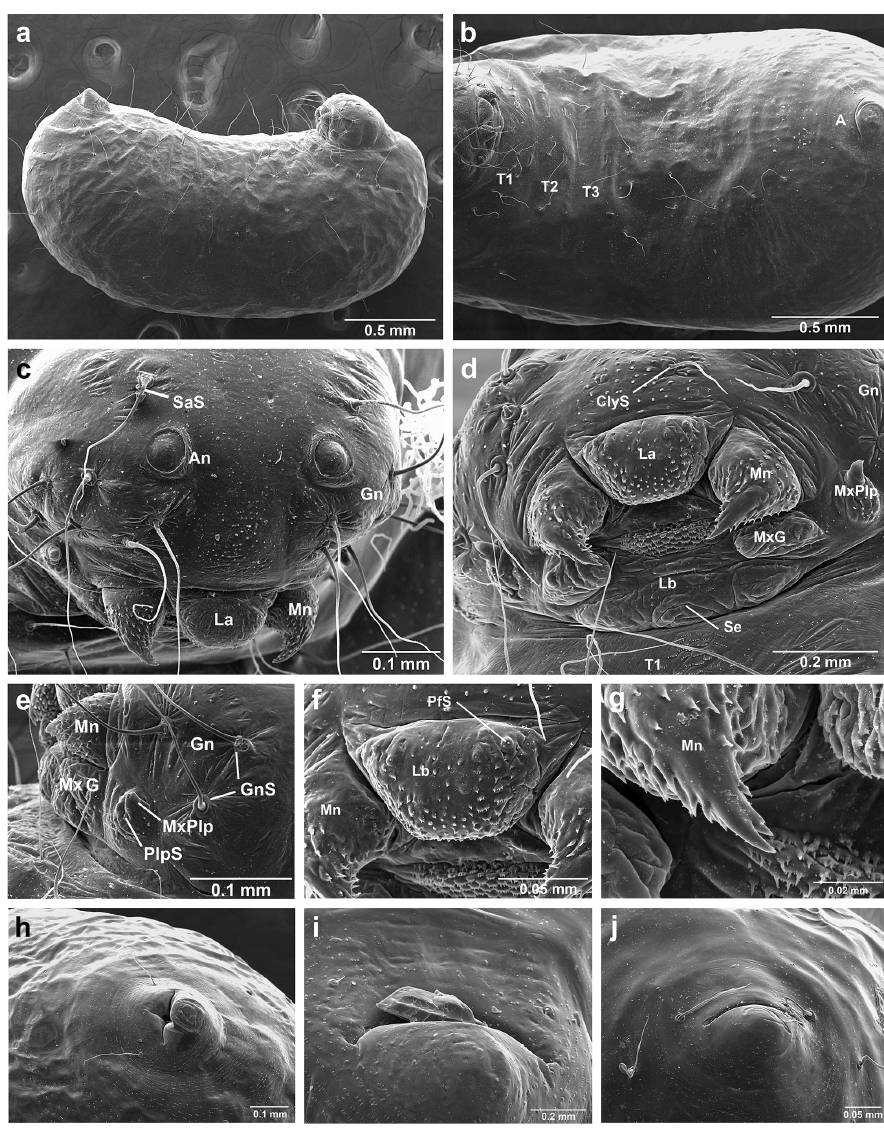
Figure 10. Sericomyrmex larval morphology, SEM images. a Lateral view b ventral view c head, frontodorsal view d mouthparts, ventral view e head, lateral view f labrum detail g mandible detail h, i, j anal setae. T1 , T2 , T3 Thoracic segments 1, 2, and 3 A anus SaS supra-antennal seta An antenna Gn gena La labrum Mn mandible MxG maxillary galea Lb labium Se sericteries MxPlp maxillary palp ClyS clypeal seta GnS genal setae PlpS maxillary palp sensillum PfS papilliform seta. Subapical mandibular tooth absent, mandibular apical tooth distinct, divided in some species (Figure 10g), undivided in others. Mandibular gnathobases absent. Basal por- tion of maxilla fused with head capsule, maxillary palp digitiform, widely